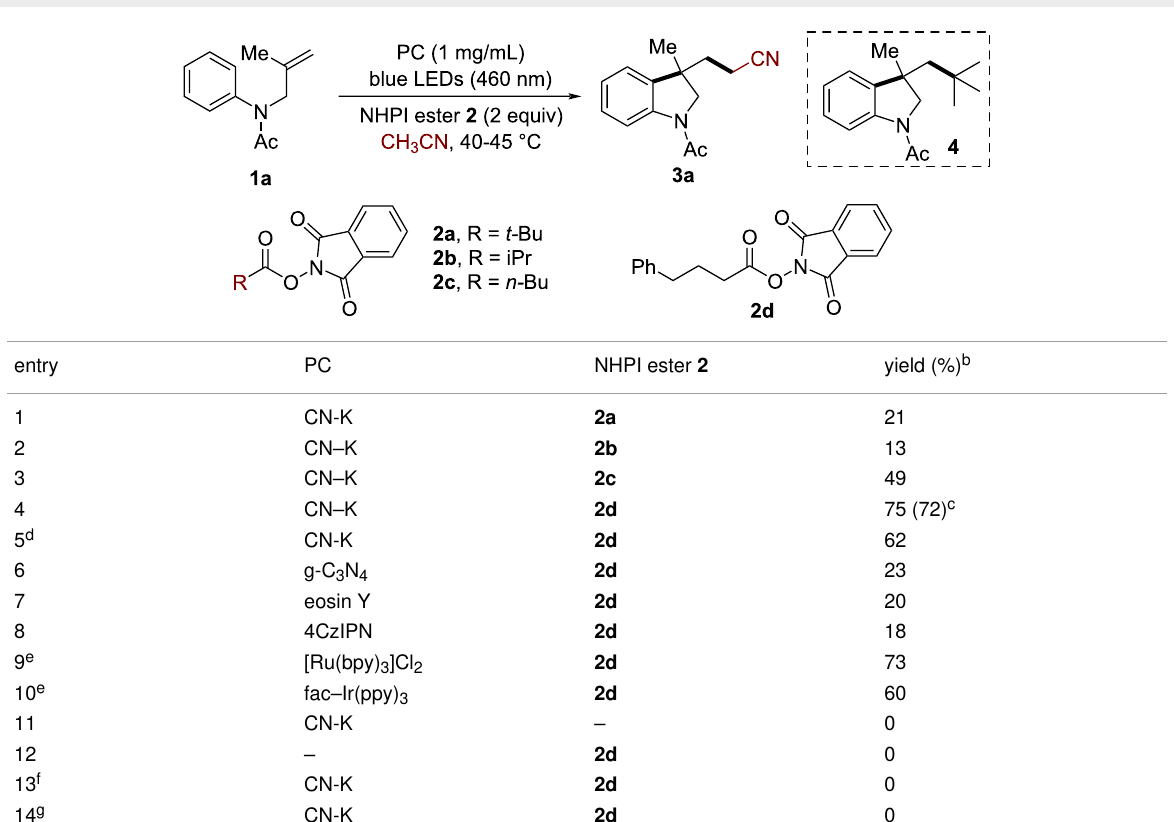
Table 1: Optimization of the reaction conditions and control experiments a